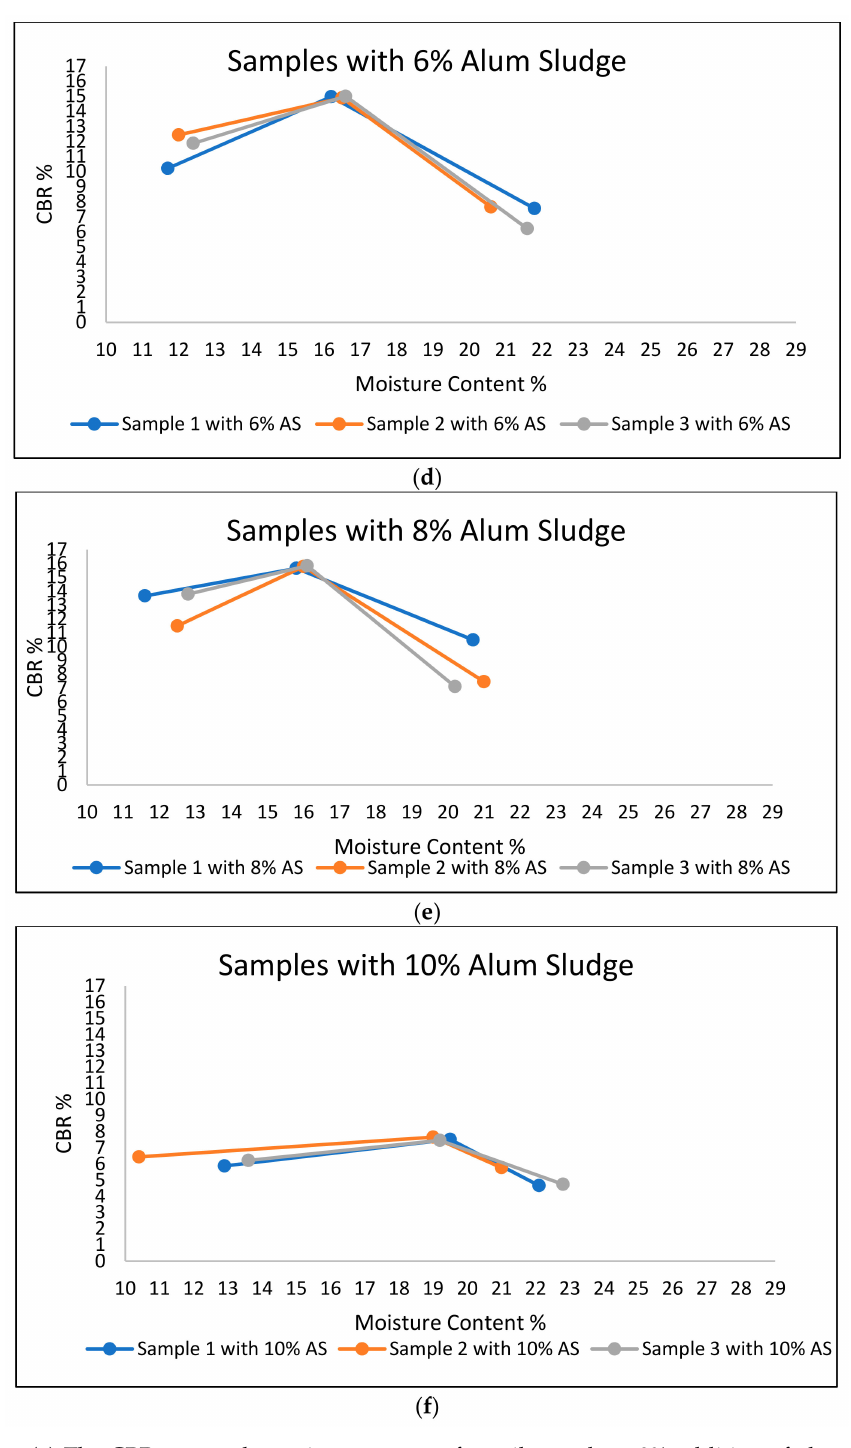
Figure 3. ( a ) The CBR versus the moisture content for soil sample at 0% addition of alum sludge; ( b ) The CBR versus the moisture content for soil sample at 2% addition of alum sludge. ( c ) The CBR versus the moisture content for soil sample at 4% addition of alum sludge; ( d ) The CBR versus the moisture content for soil sample at 6% addition of alum sludge; ( e ) The CBR versus the moisture content for soil sample at 8% addition of alum sludge; ( f ) The CBR versus the moisture content for soil sample at 10% addition of alum